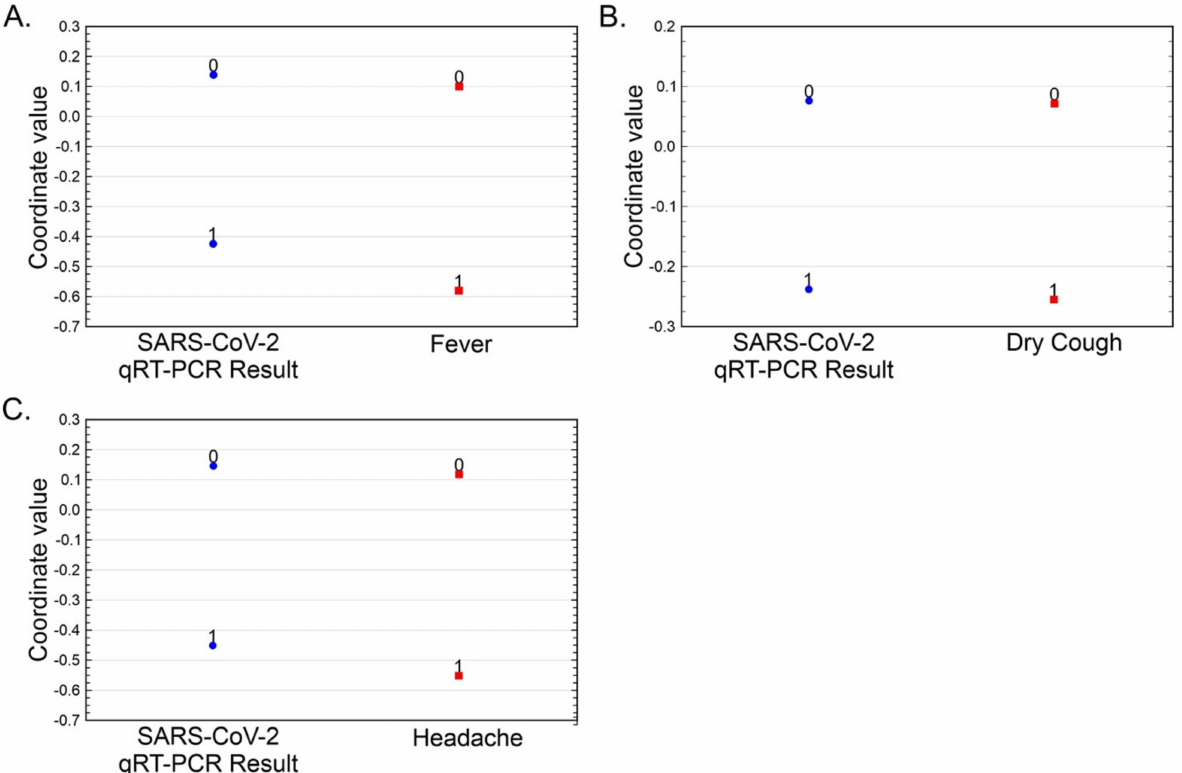
Figure 2. Correspondence analysis of SARS-CoV-2 qRT-PCR results and the symptoms with the stronger predictive value. Tables of 2 × 2 from SARS-CoV-2 qRT-PCR results. Each symptom is used as input and represented as a one-dimensional plot. The three symptoms with the strongest SARS-CoV-2 qRT-PCR predictive value ( p < 0.001) are displayed in the figure: ( A ) fever, ( B ) dry cough, and ( C ) headache. The Eigenvalues calculated with 100% inertia were 0.05963 for fever, 0.01945 for dry cough, and 0.06573 for